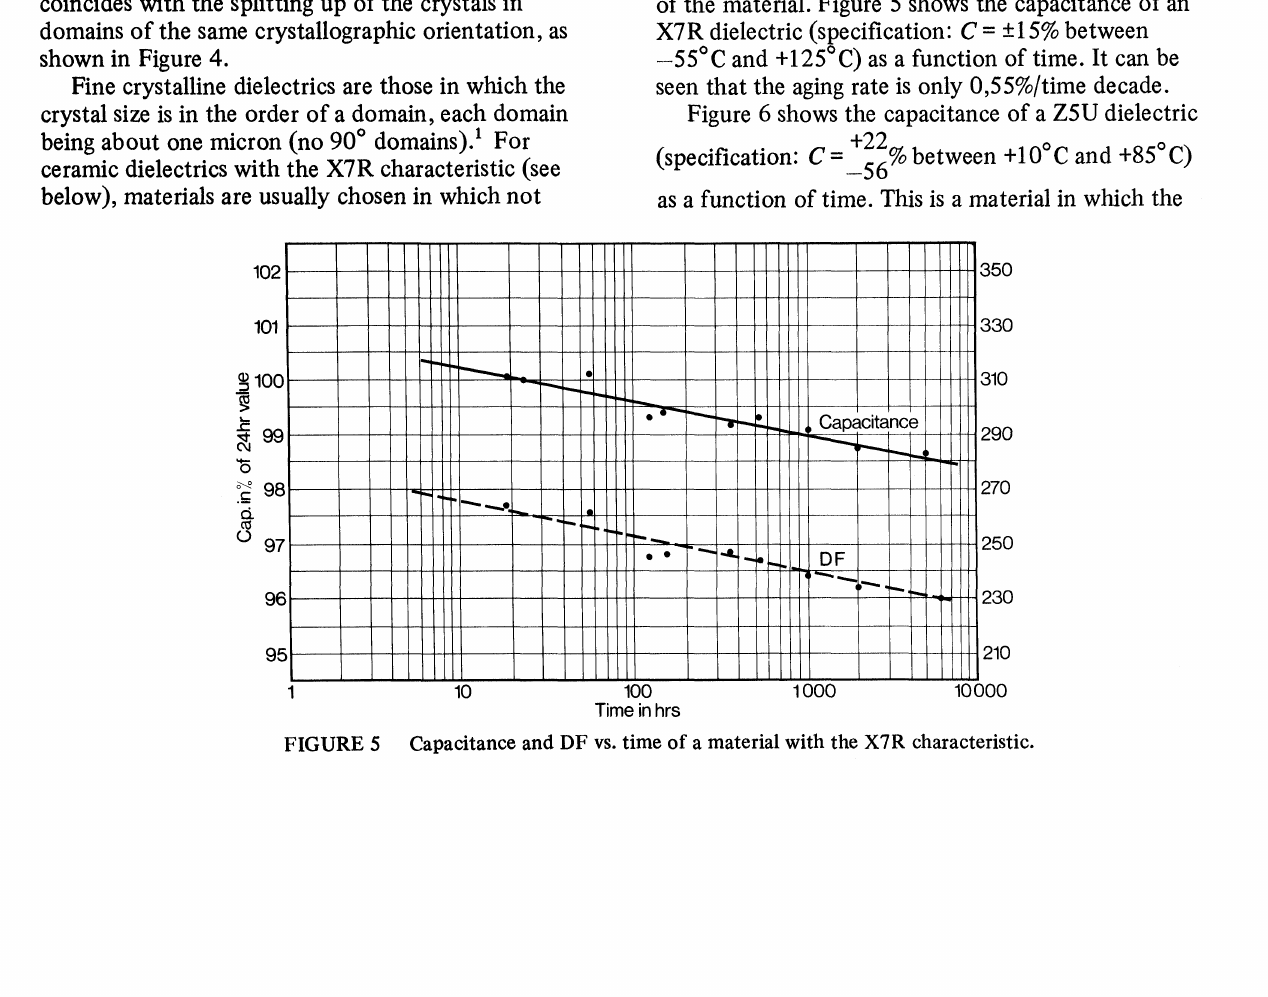
FIGURE 4 Domain structure in BaTiO3 based ceramic. \ Capacitance vs. temperature ZSU characteristic.